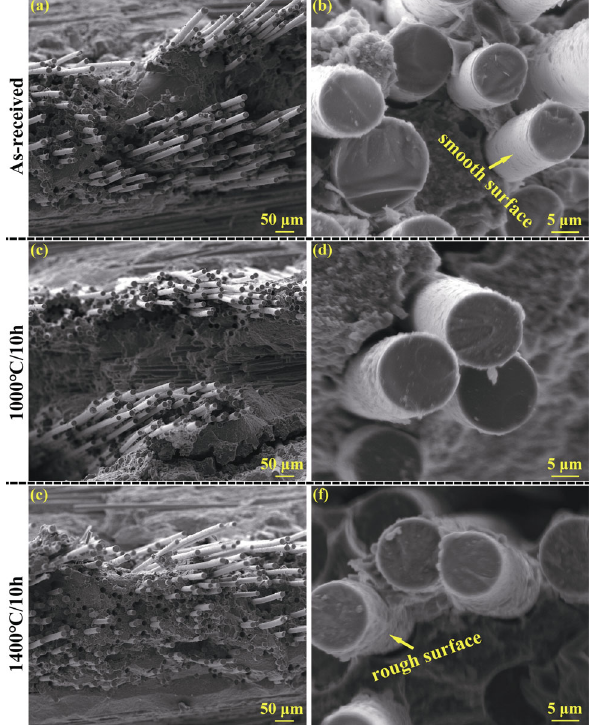
Fig. 8 SEM images of the SiC f /SiC composite fracture surfaces: as-received (a, b) and heat treated at 1000 ℃ (c, d) and 1400 ℃ (e, f) for 10